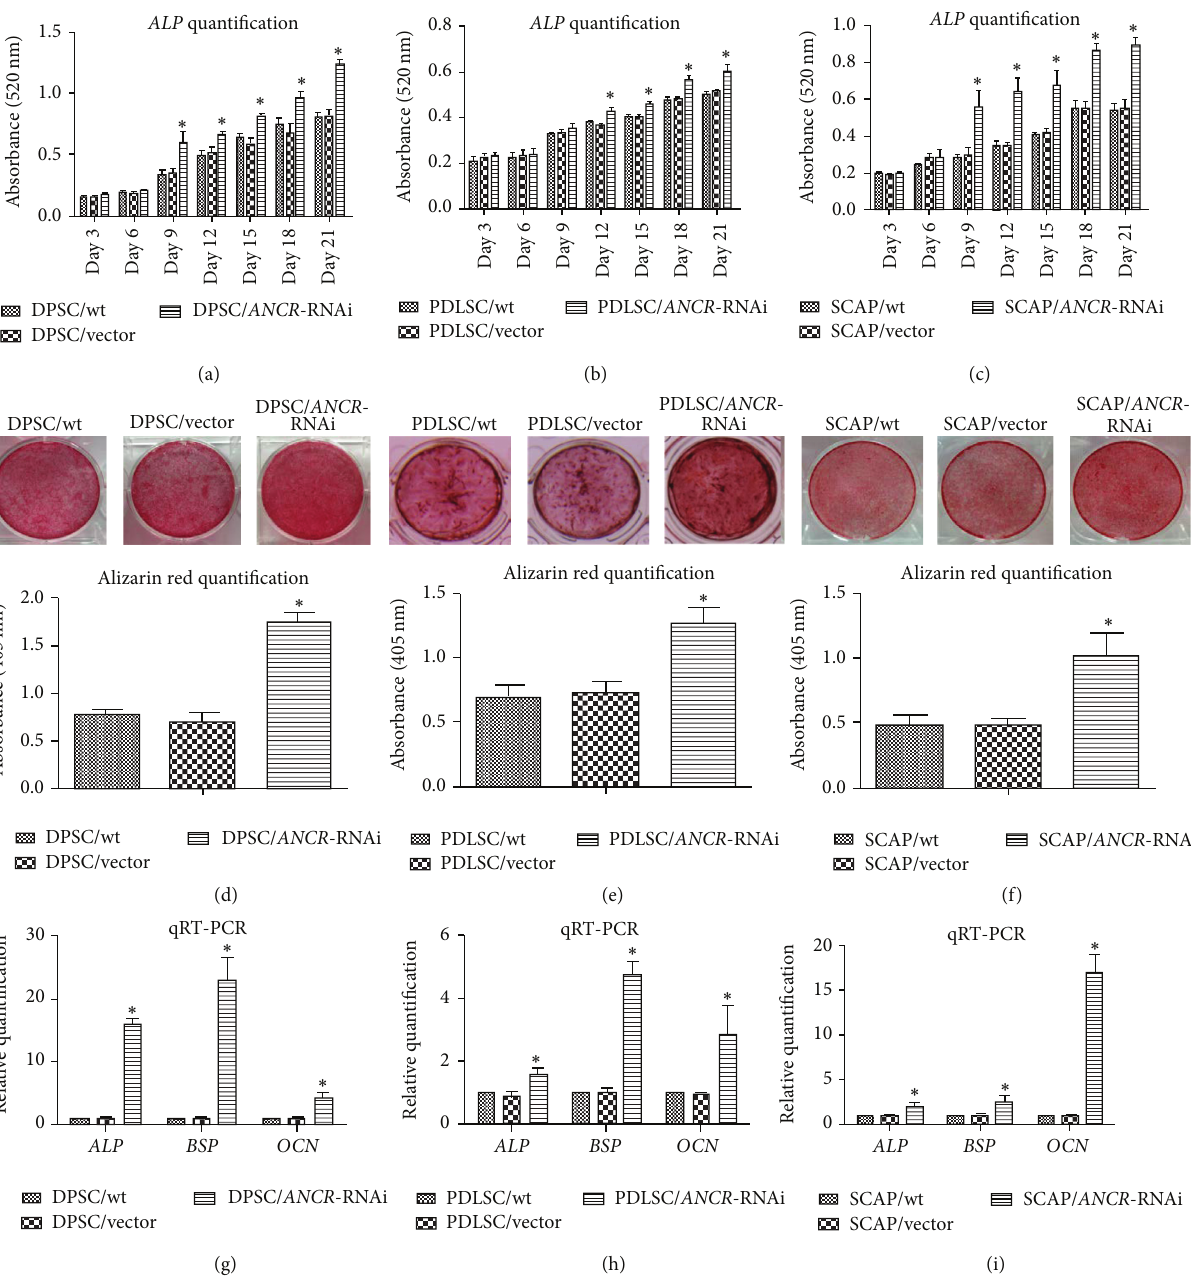
(g) (h) Figure 3: The effect of ANCR -RNAi on osteogenic differentiation in DTSCs. ALP activity was significantly increased in DPSC/ ANCR -RNAi (a), PDLSC/ ANCR -RNAi (b), and SCAP/ ANCR -RNAi (c) cells when compared with control cells. Three weeks after induction, the cells were stained with Alizarin red (pH = 4.1), and DPSC/ ANCR -RNAi (d), PDLSC/ ANCR -RNAi (e), and SCAP/ ANCR -RNAi (f) cells formed more mineralized nodules than the control groups. The Alizarin red quantification confirmed this result. The mRNA expression of ALP , BSP, and OCN was upregulated in DPSC/ ANCR -RNAi (g), PDLSC/ ANCR -RNAi (h), and SCAP/ ANCR -RNAi (i) cells compared with control cells after two weeks of induction. ∗ 𝑃 < 0.05 when compared with the control